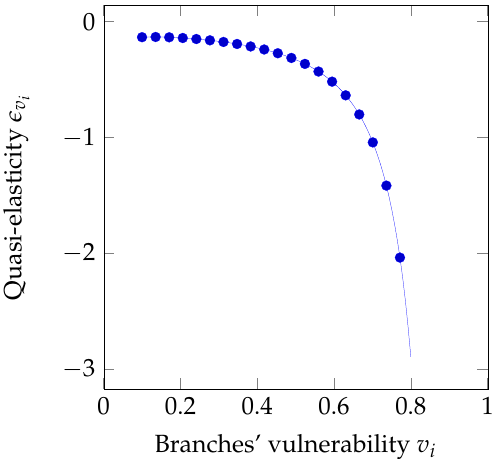
Figure 20. Sensitivity to branches’ vulnerability under full liability.